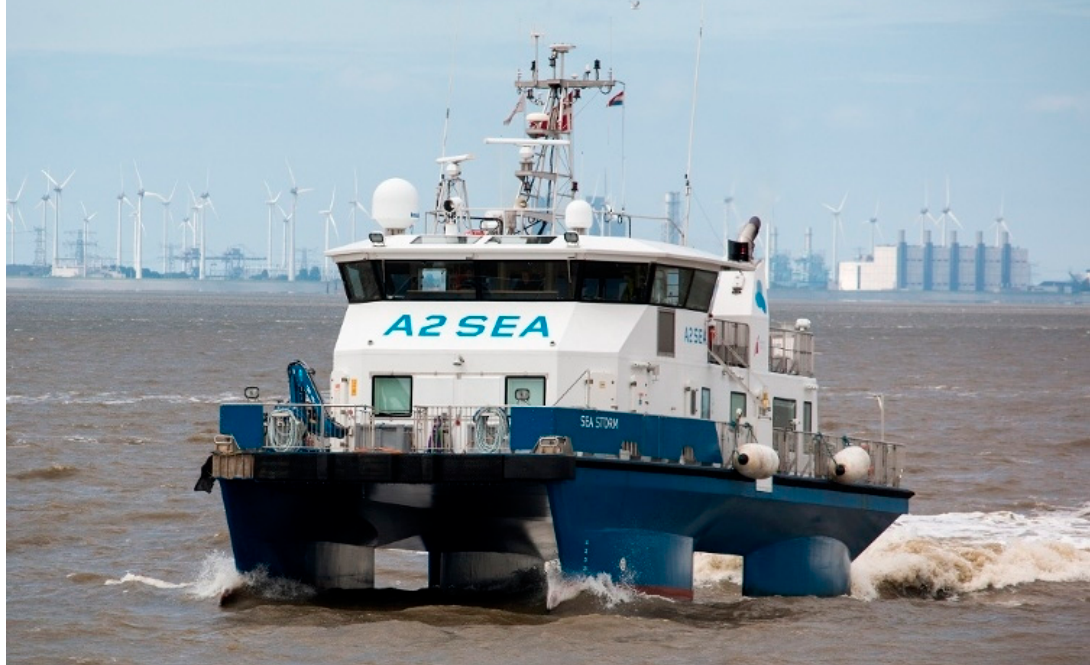
Figure 3. SWATH GENERATION II–M/V FOB SWATH 4, IMO 9672947, (former SEA STORM) [51].